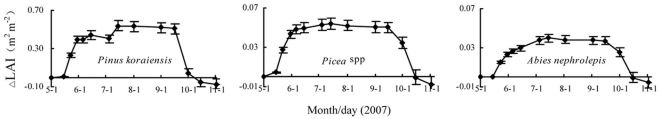
LAI of total coniferous species in the study site estimated by the increased LAI from leaf seasonality observations minus the decreased LAI from litter trap data.Error bars represent the standard error.